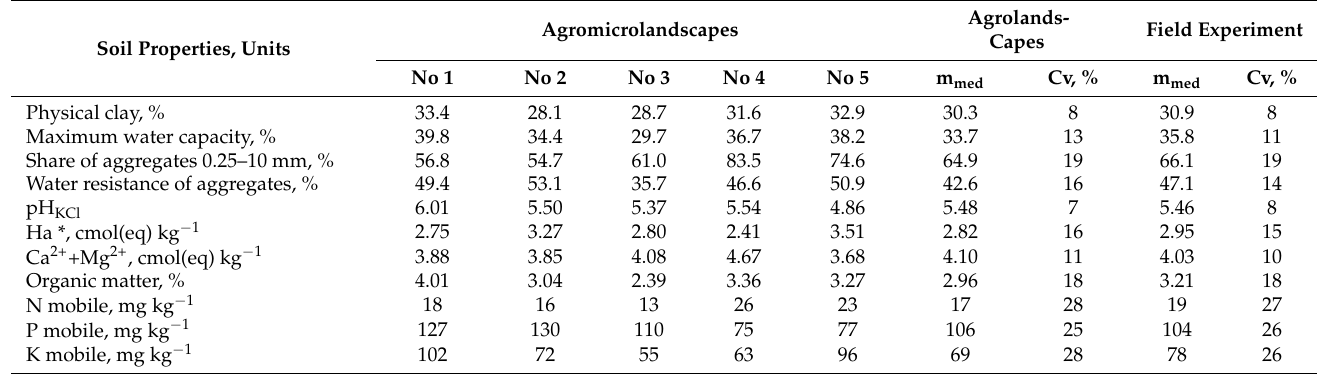
Table 1. Agrophysical and agrochemical soil properties in the